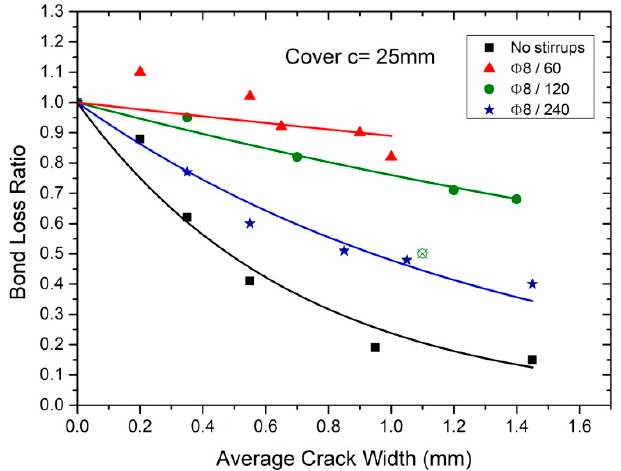
Figure 9. Exponential predictive models of bond loss in function with average crack width [21].